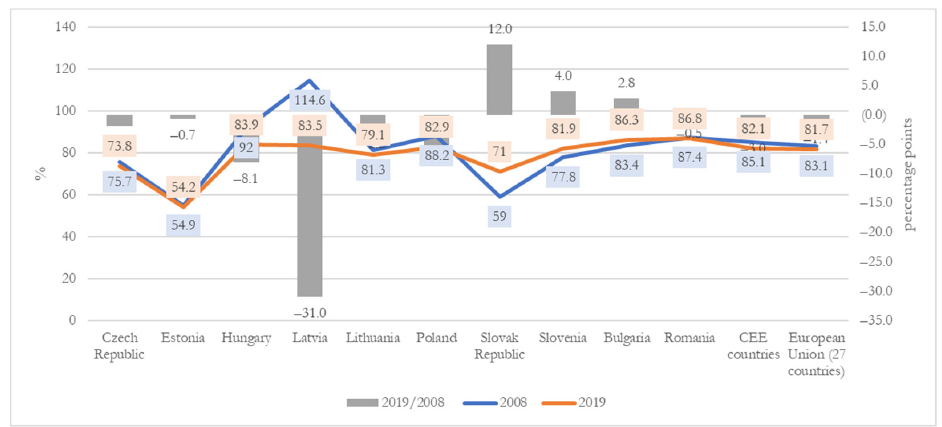
feed) while in the Slovak Republic, the importance of this sector is shown by an increase of 12 percentage points during 2008–2019 period. crease of 12 percentage points during 2008–2019 period.